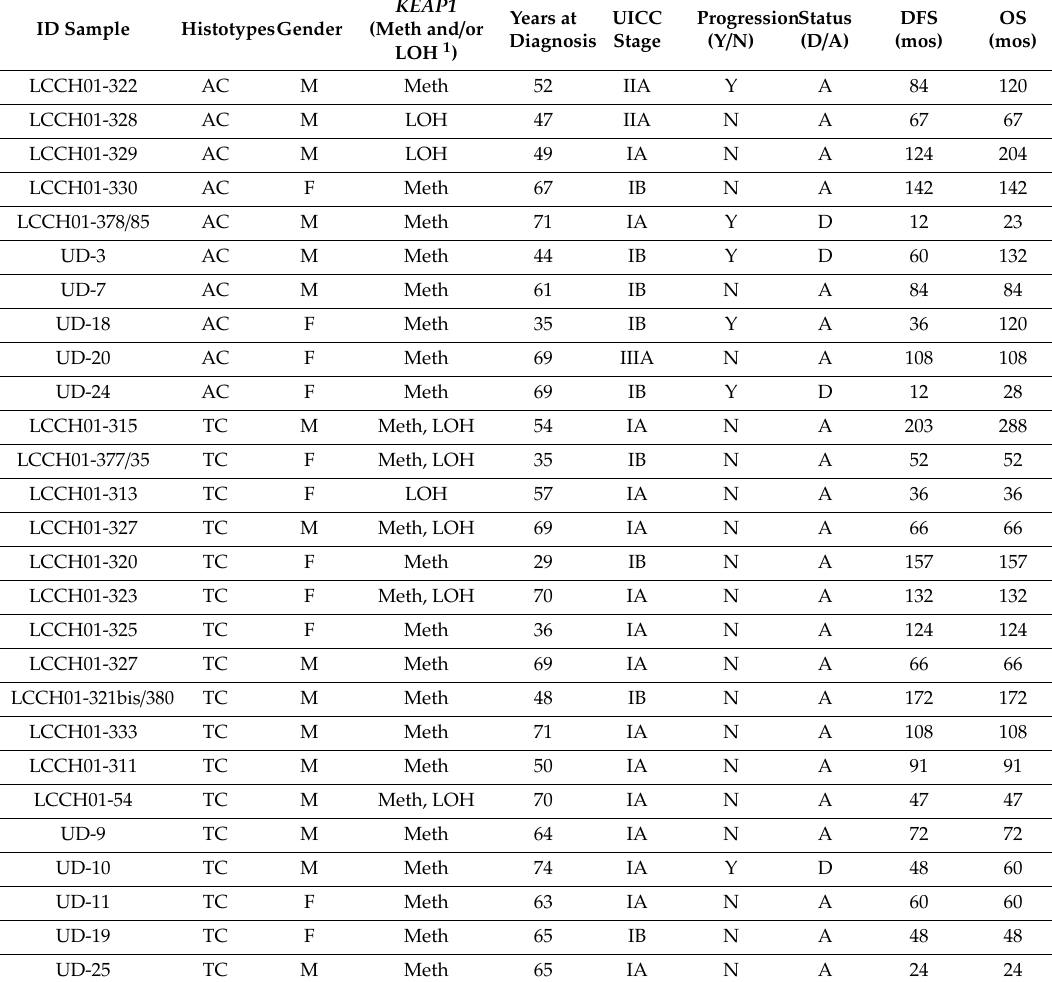
Table 1. Clinical-pathological features of lung carcinoid samples harboring KEAP1 molecular